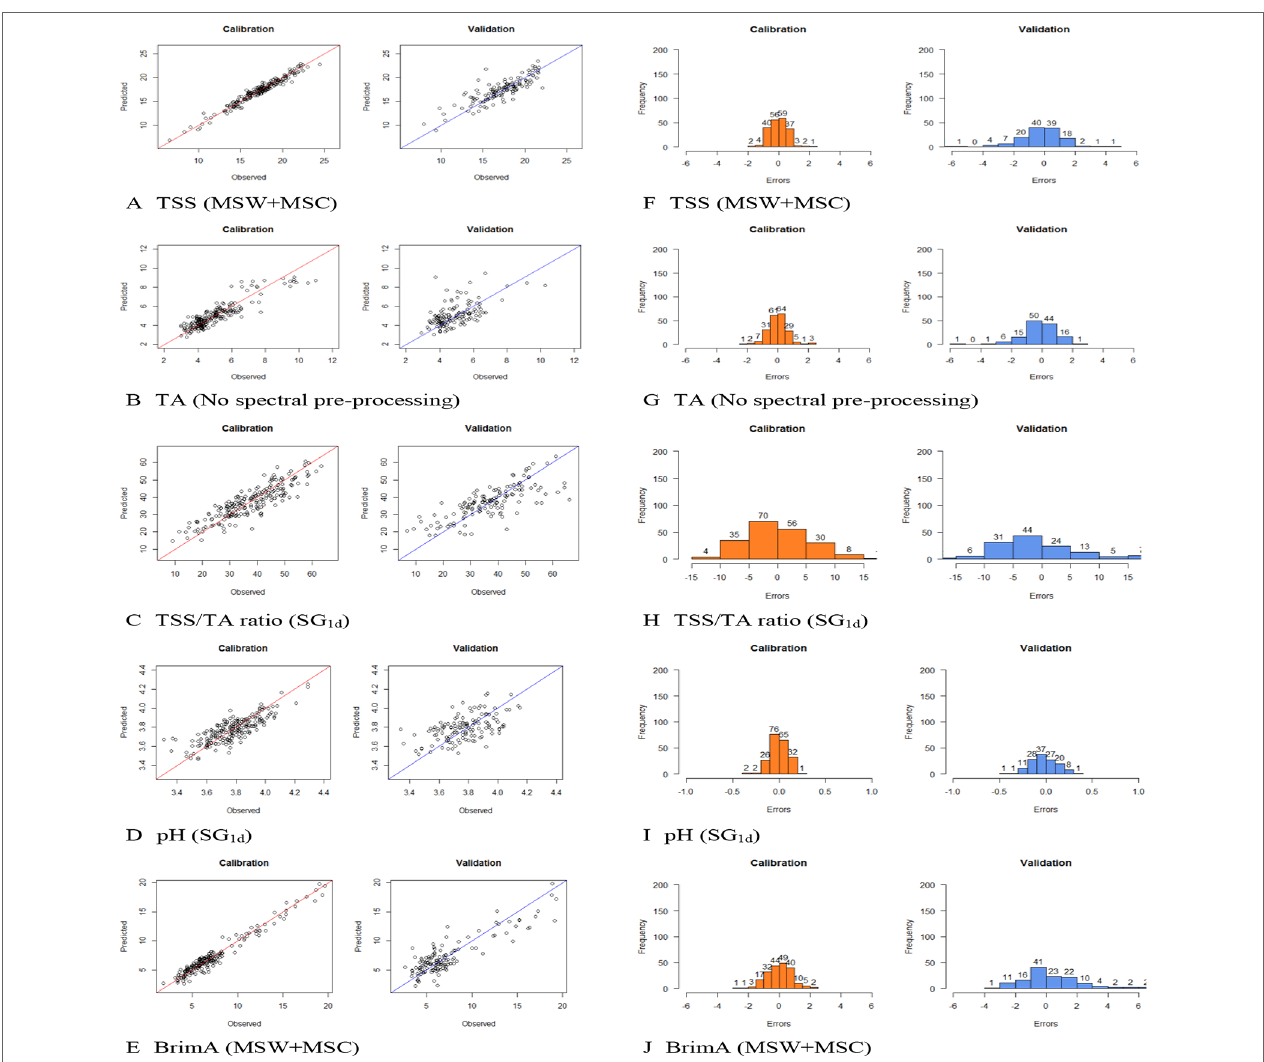
FIGURe 4 | Calibration and validation plots of the models obtained for the five parameters and the spectral preprocessing methods applied to the raw spectra during the construction process; (A) total soluble solids (TSS), (B) titratable acidity (TA), (C) TSS/TA ratio, (D) pH, and (e) BrimA as well as the distribution of the errors obtained for each model (F) TSS, (G) TA, (h) TSS/TA, (I) pH, and (J) BrimA.